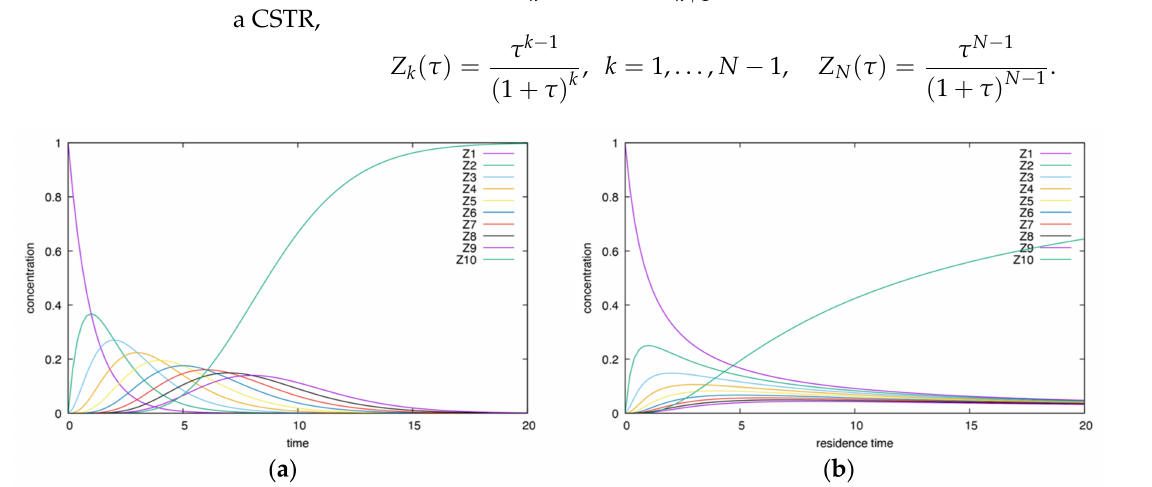
Figure 1. Evolutions in a BR ( a ) and in a CSTR ( b ) of the acyclic irreversible mechanism, N =